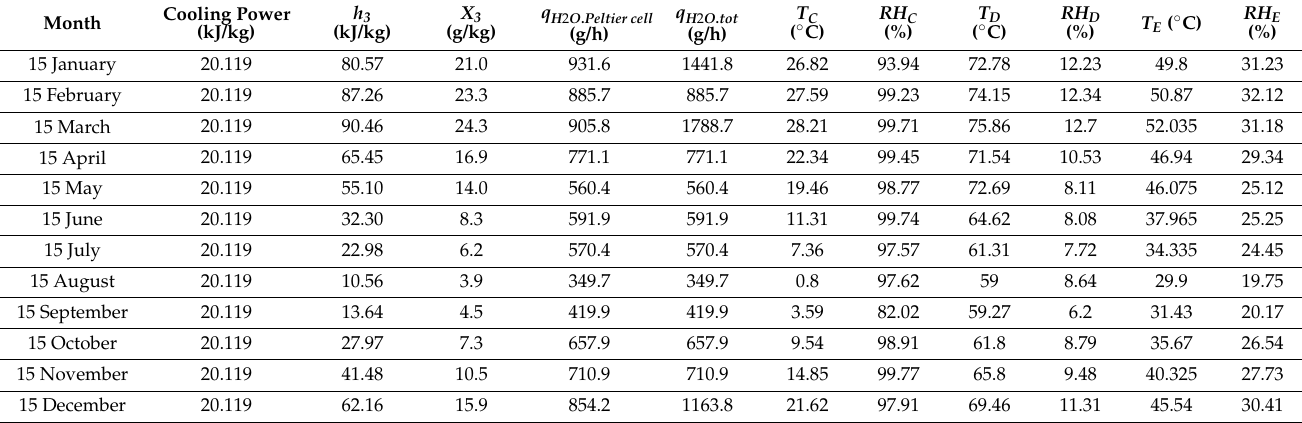
Table 6. Calculation of condensed water using 3 Peltier